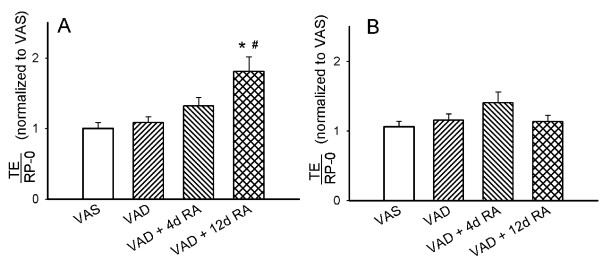
Tropoelastin (TE) mRNA was increased in the lung parenchyma after retinoic acid (RA) administration. Lung parenchymal (A) and bronchial (B) tissues were separated prior to RNA isolation. The filters from Northern analysis were re-probed for the constitutively expressed mRNA for ribosomal phosphoprotein P-0 (RP-0) to correct for differences in the amounts of RNA loaded. The density of TE mRNA was expressed relative to that for RP-0 for each lane, and normalized to the mean density for RNA from VAS rats within each Northern analysis. Data are mean ± SEM, n = 9 rats for each retinoid-treatment condition. Treatment with RA for 12 days (VAD + 12d RA) increased lung but not bronchial TE mRNA (*) p < 0.05, 2-way ANOVA. Treatment with RA for 4 days (VAD + 4d RA) did not significantly increase lung or bronchial TE mRNA.